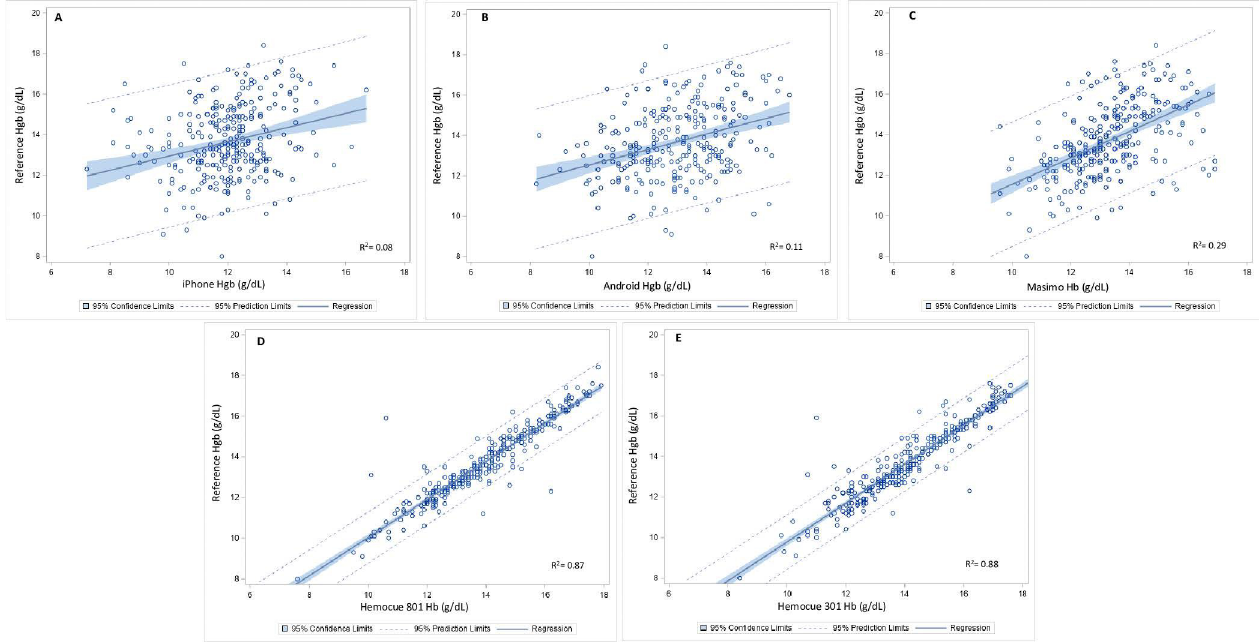
Fig 1. Correlation assessment of each test device (A = Apple 1 ; B = Android 1 ; C = Masimo Pronto 1 ; D = HemoCue 1 Hb-301; E = HemoCue 1 Hb-801) with Hgb reference (CBC hematology analyzer).